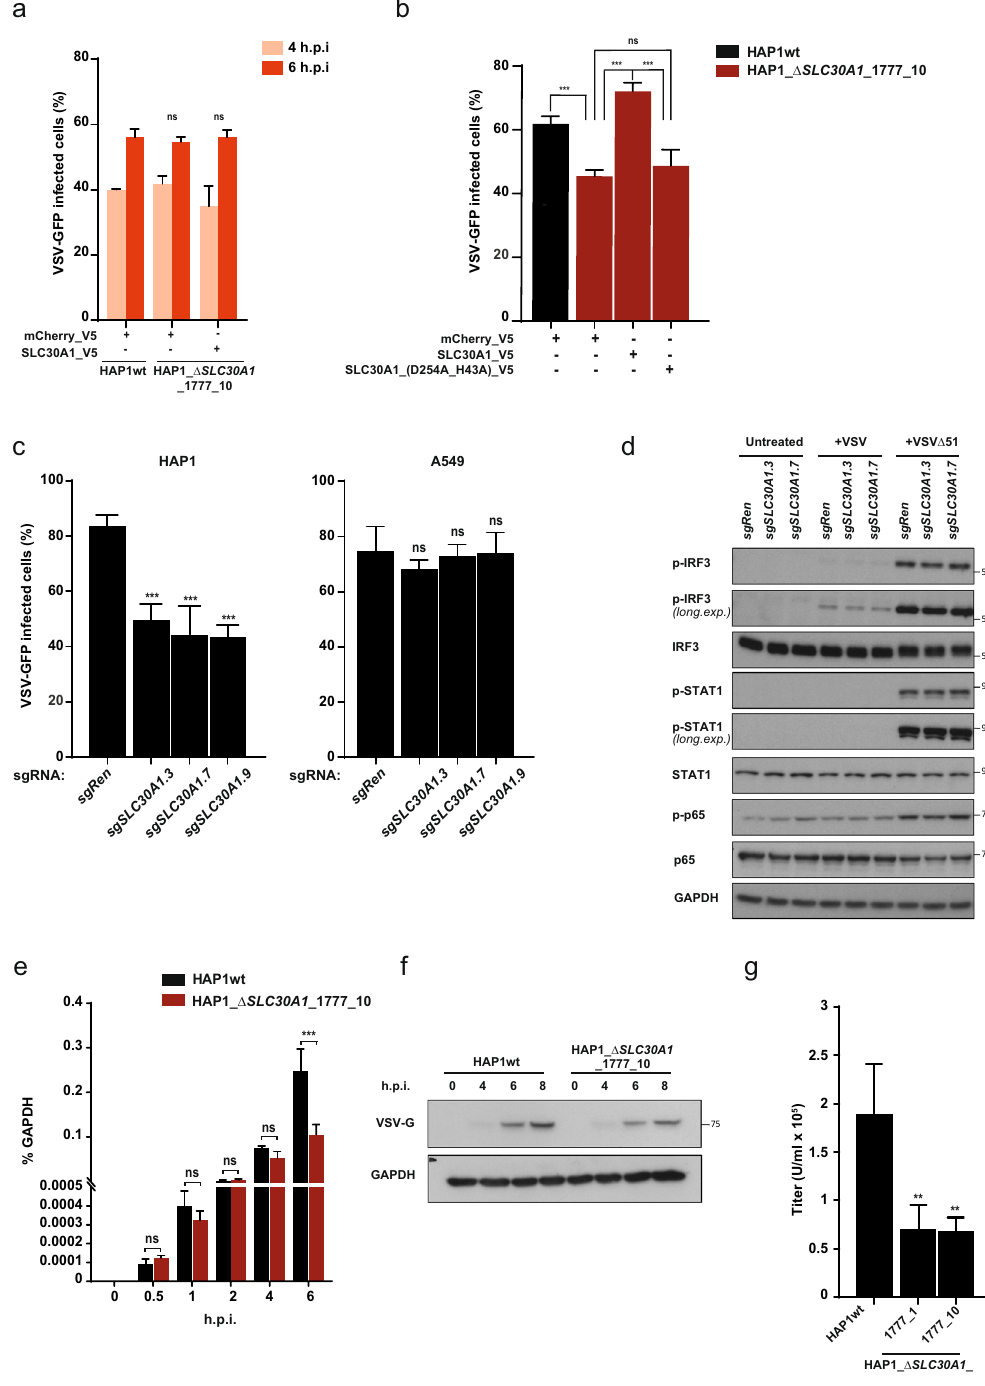
Figure 3. SLC30A1 loss affects VSV infection through modulation of Zn levels. ( a – c ) VSV-GFP virus replication in SLC30A1 knockout HAP1 cells ( a , c ) and HAP1 cells overexpressing wild type SLC30A1 and SLC30A1(D254A_H43A) cDNAs ( b ) and A549 cells ( c ). Cells were infected with MOI 1 ( a ), MOI 0.001 ( b ) and MOI 0.002 ( c ). The number of GFP + cells was quantified using flow cytometry at 14 h.p.i. ( b , c ) or indicated time points ( a ). ( d ) Immunoblot analysis of type I IFN/STAT1 signalling pathway activation in the VSV-infected (MOI 2) HAP1 cells carrying sgRNAs against SLC30A1 and Renilla luciferase control. Cropped images are shown for conciseness. Full-length blots are presented in Supplementary Fig. 5. ( e ) Quantitative RT-PCR of total viral RNA in the HAP1 wild type cells and a SLC30A1 single cell knockout clone at different points after VSV infection (MOI 2). ( f ) VSV-G protein levels in the HAP1 wild type cells and SLC30A1 single cell knockout clone at different points after VSV infection (MOI 2). Cropped images are shown for conciseness. Full-length blots are presented in Supplementary Fig. 5. ( g ) Quantification (flow cytometry) of virus titers produced by HAP1wt and two SLC30A1 single cell knockout clones infected with VSV-GFP for 8 hours at MOI of 2. Statistical